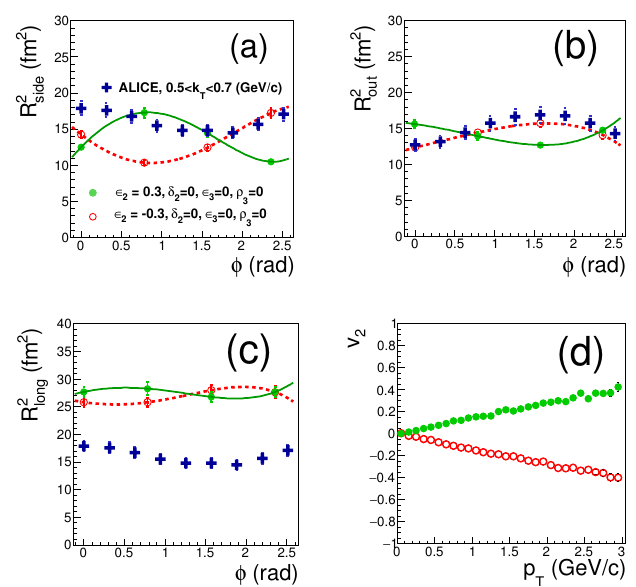
( ∆ φ ) , R 2 ( ∆ φ ) , and R 2 ( ∆ φ ) , respectively, 2 2 2 out side long √ s = 2.76 GeV